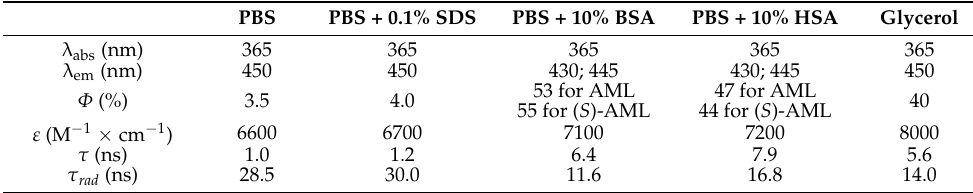
Table 1. Photophysical properties of AML in different